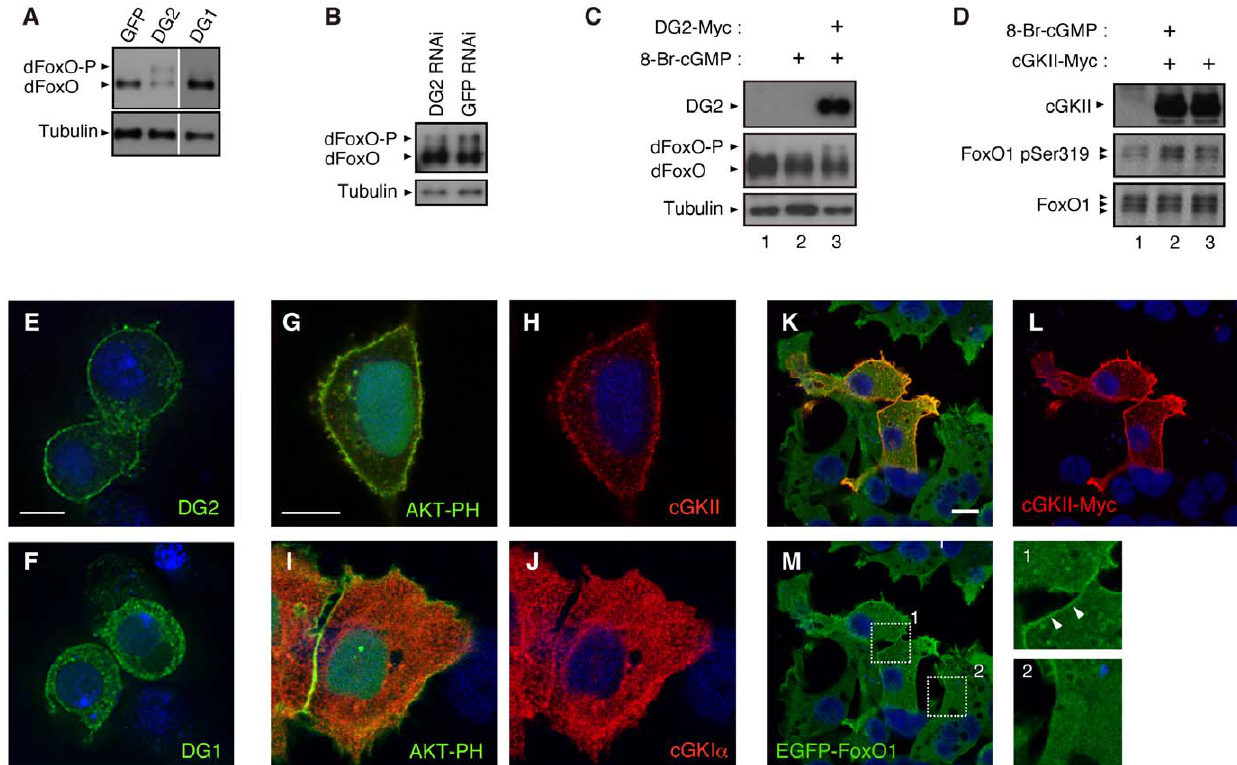
Figure 3. DG2 modulates FoxO invivo . ( A ) dFoxO and the indicated transgenes were expressed in the Drosophila eyes using the GMR-GAL4 driver. Extracts from brain tissues were subjected to western blot analysis. dFoxO-P; a phosphorylated form of dFoxO. ( B ) DG2 RNAi or GFP RNAi constructs were expressed in the Drosophila brain using the elav-GAL4 driver. Western blot analysis for endogenous dFoxO was carried out as in ( A ). ( C ) Drosophila S2 cells were transfected with or without C-terminally Myc-tagged DG2 (DG2-Myc). Thirty-six hrs post transfection, cells were treated with or without 10 m M 8-Br-cGMP for 30 min. Cell lysate were then subjected to western blot analysis. ( D ) Human 293T cells were transfected with or without cGKII-Myc, and were treated with 8-Br-cGMP as in ( C ). Phosphorylation of the S319 site in endogenous FoxO1 was detected with phospho- specific antibody. ( E, F ) S2 cells expressing DG2-Myc ( E ) or DG1-Myc ( F ) were visualized with anti-Myc antibody (green), by counterstaining with DAPI (blue color). ( G–J ) HeLa cells expressing AKT-PH-GFP (green) along with cGKII-Myc ( G, H ) or cGKI-Myc ( I, J ) were visualized with anti-Myc antibody (red), by counterstaining with DAPI (blue color). AKT-PH-GFP was used for a marker protein of the plasma membrane [62]. ( K – M ) Flp-In T-REx-293 cells harboring EGFP-FoxO1 gene were transiently transfected with cGKII-Myc, and EGFP-FoxO1 was induced with doxycycline. Enlarged views of the plasma membrane regions in cGKII-positive (Box1) and negative (Box2) cells are also shown in ( M ). Accumulation of FoxO1 along with cGKII in the plasma membrane is indicated by arrowheads. Scale bars=5 m m for ( E, F ), 25 m m for ( G–J ) and 10 m m for ( K–M ).